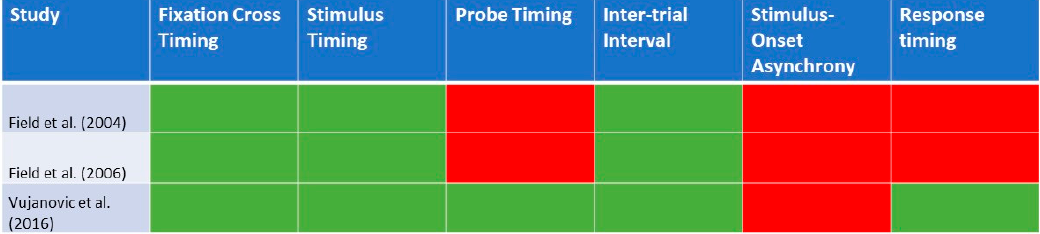
Figure 2. A graphical representation of the details of the Visual Probe Task that were reported in each of the identified studies for cannabis use disorder (n = 3). Green highlights: reported in study; red highlights: not reported in study.